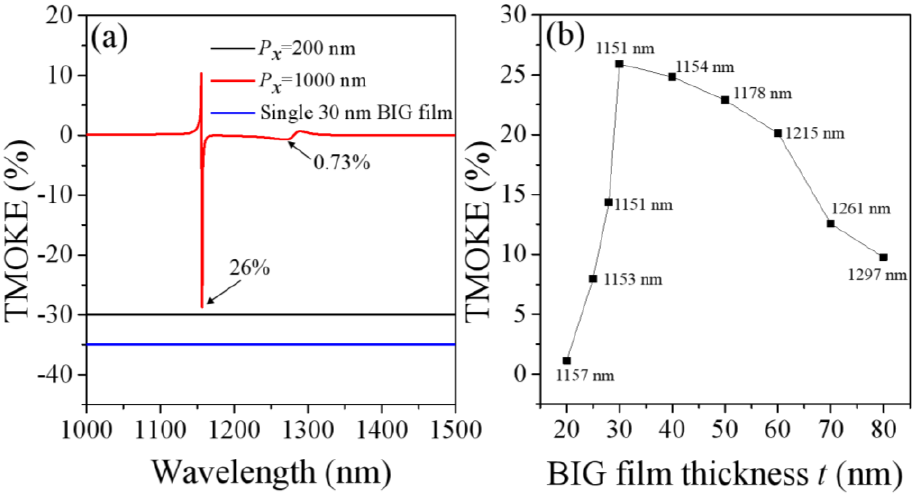
Figure 5. ( a ) The TMOKE spectra for the designed metasurface with the period P x = 1000 nm (red line). For the comparison, the TMOKE spectrum for the designed metasurface with the period P x = 200 nm and the single 30 nm BIG film are also given by the black and blue line, which are shifted vertically for better visibility. ( b ) The maximum intensity of the TMOKE signal for metasurface with the different BIG film thickness ( t ), with the period P x = 1000 nm.